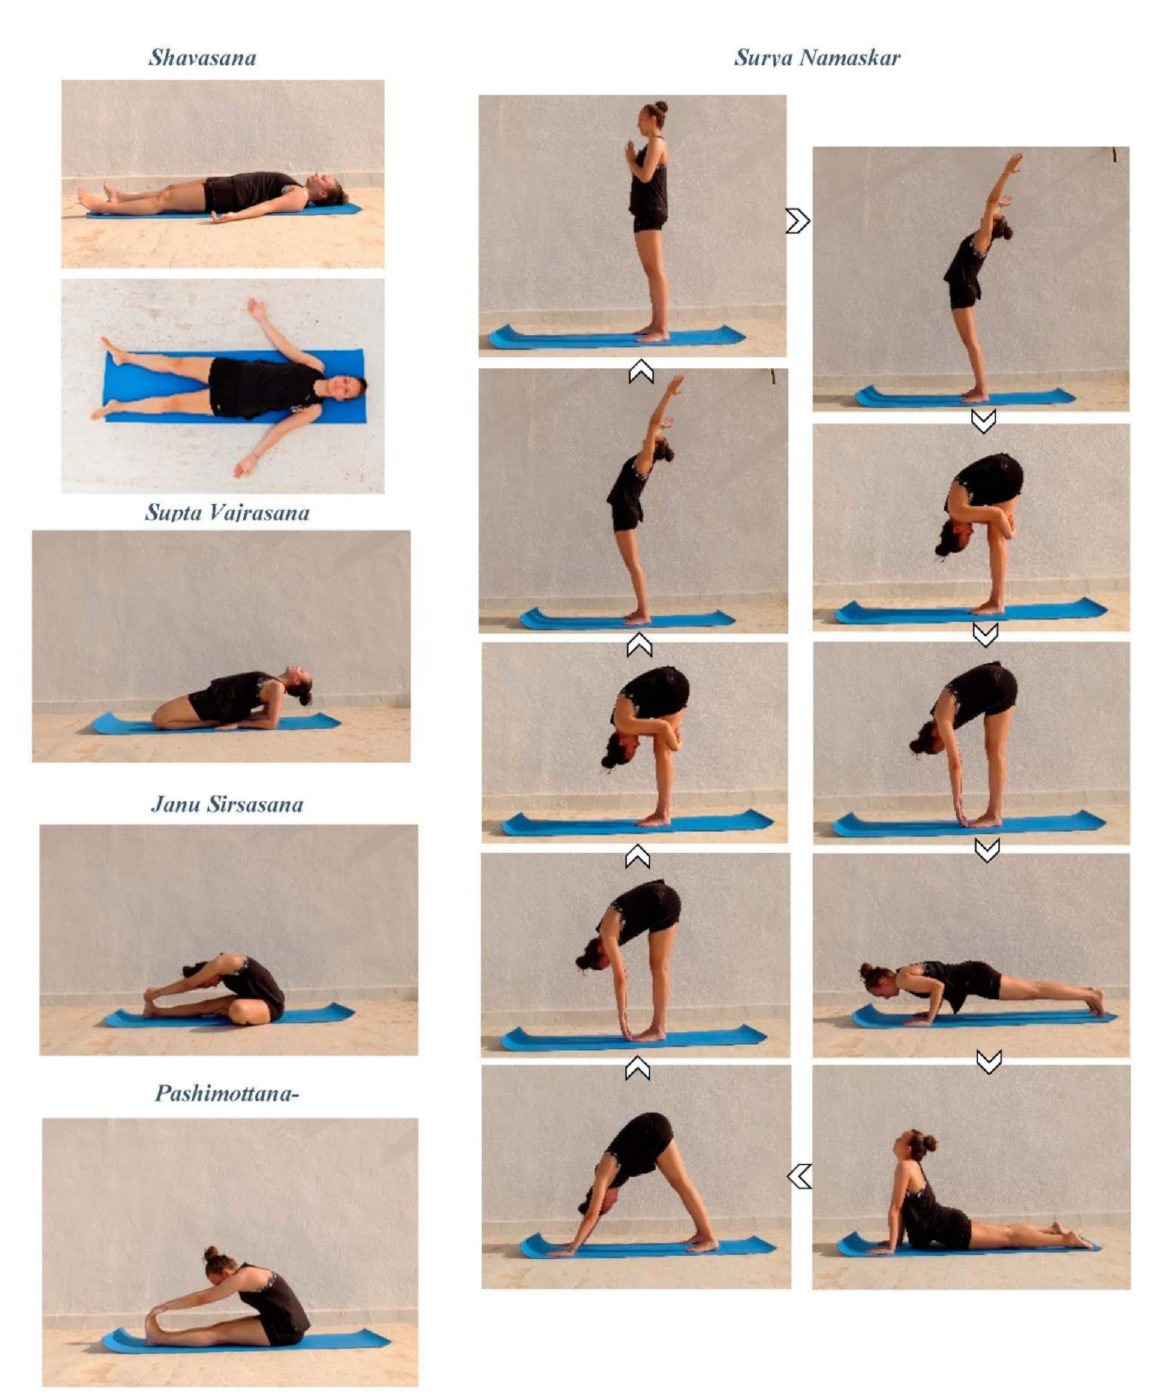
Figure A2. Yoga positions for dysmenorrhea